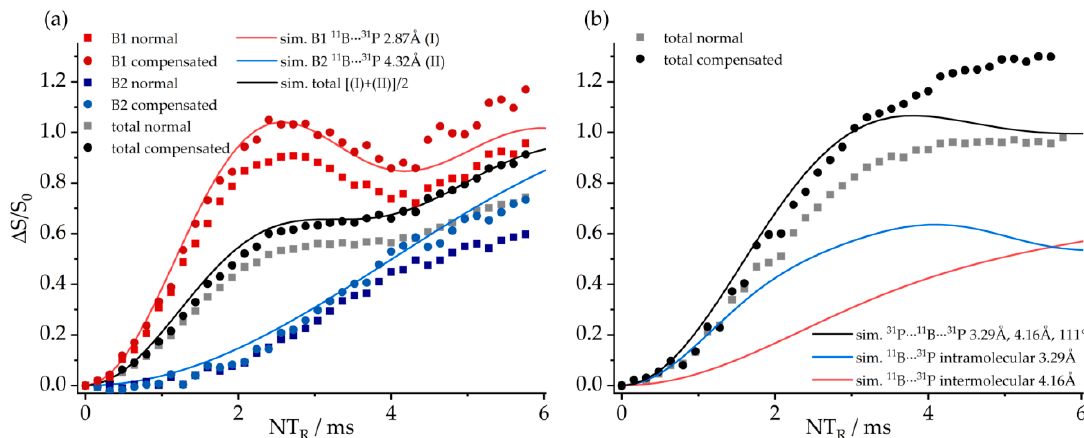
Figure 28. Individual 11 B{ 31 P} REDOR (squares) and compensated REDOR (circles) curves (see Figure 11) obtained for the integrated signal intensity of ( a ) 8 and ( b ) 7 . In the case of 8 , solid curves are two-spin simulations based on the crystal structure with 11 B ... 31 P distances of 2.87 Å (red curve, B1) and 4.32 Å (blue curve, B2). Black data points and solid curves show the weighted sum obtained if the total signal intensity is analyzed. In the case of 7 , simulations are shown for two-spin systems of intramolecularly and intermolecularly interacting 11 B and 31 P nuclei with internuclear distances of 3.29 Å (blue curve) and 4.16 Å (red curve). The black curve shows a three-spin simulation based on both distances and a 31 P ... 11 B ... 31 P angle of 111 ◦ reflecting the structural situation in the crystal structure.